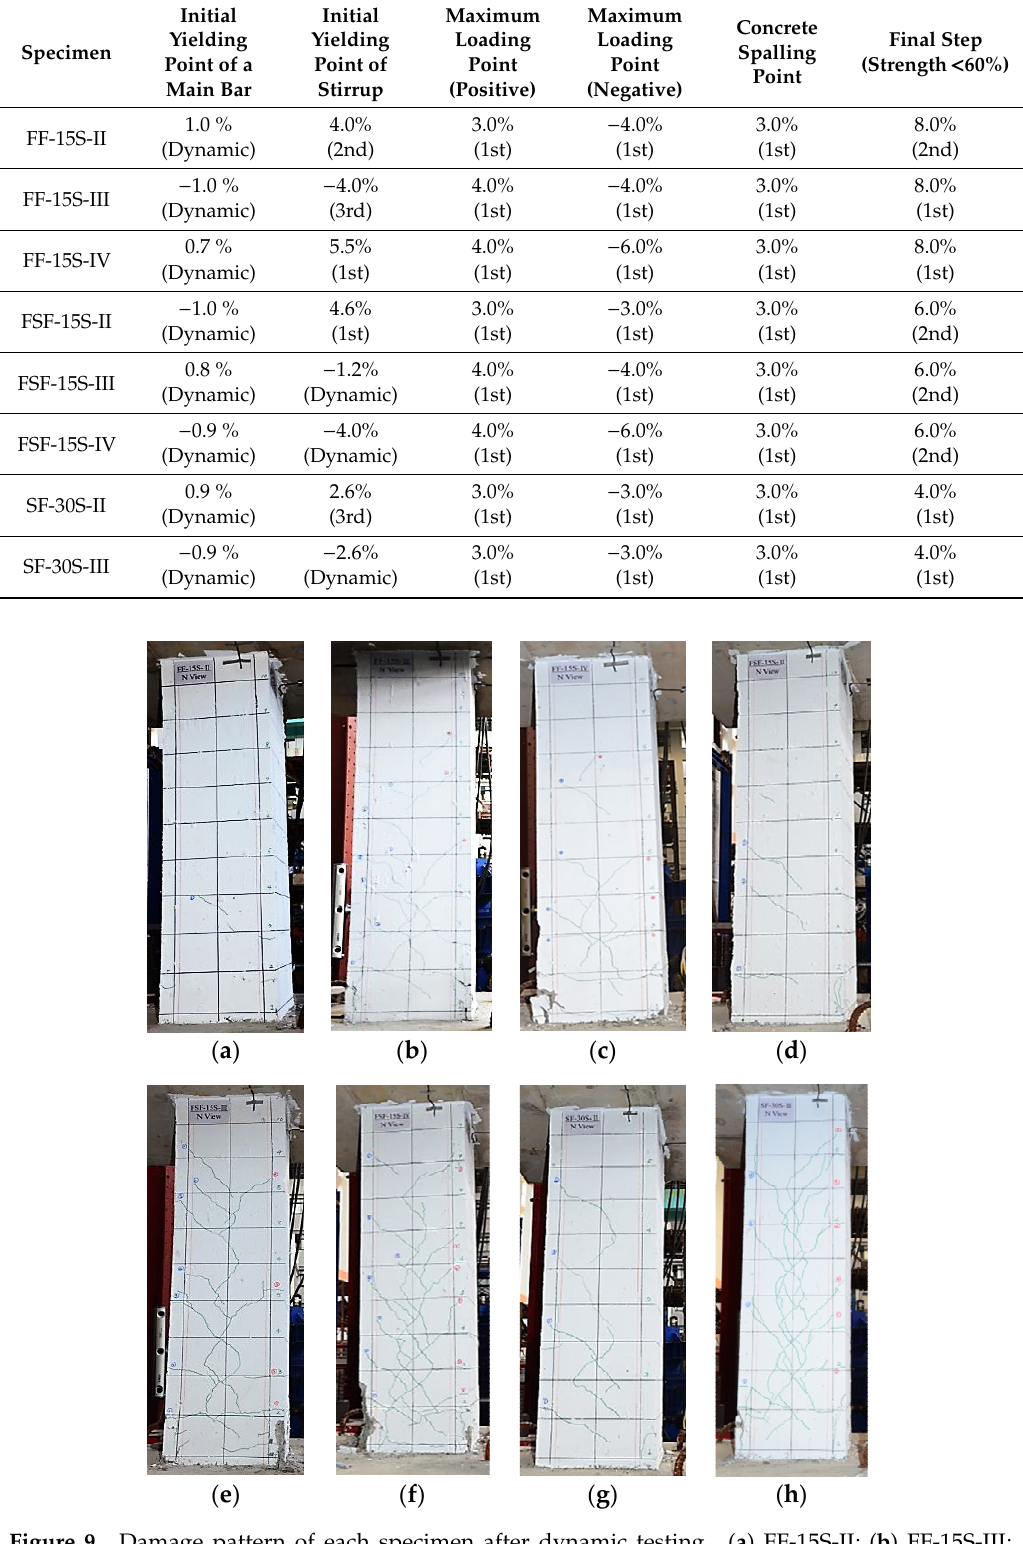
Table 4. Definition of damage levels in JBDPA [25,26]. Damage Levels ( c ) Figure 10. Maximum residual crack widths for each specimen. ( a ) FF-15S; ( b ) FSF-15S; ( c ) SF-30S . 4. Proposed Method for Detecting Force Applied to a Column Specimen in an Earthquake 4.1. Voltage Signals Generated by Post-Embedded Piezoceramic Sensors under Dynamic Loading Since the lateral force excitation from the dynamic actuator induced the piezoelectric effect of the post-embedded piezoceramic sensors in each specimen, the sensors produced the voltage signals under the dynamic testing. For Sensor 1 and Sensor 2 in each specimen, charge amplifiers were used